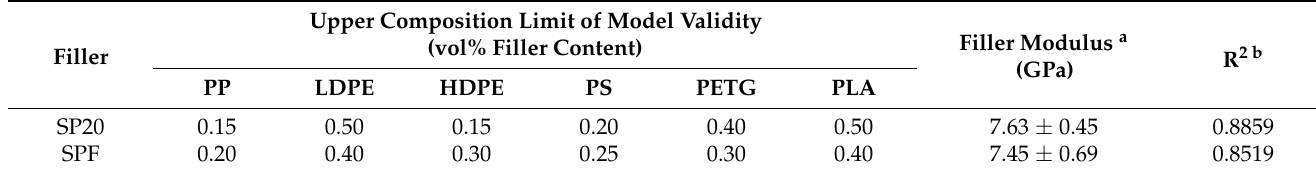
and the reversible work of adhesion in their composites.